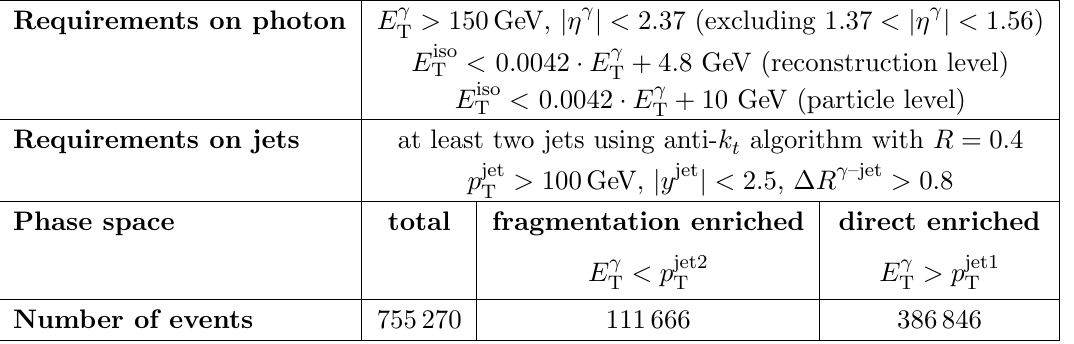
Table 1 . Phase-space regions for the measurements and predictions. The number of data events selected in each phase space is also